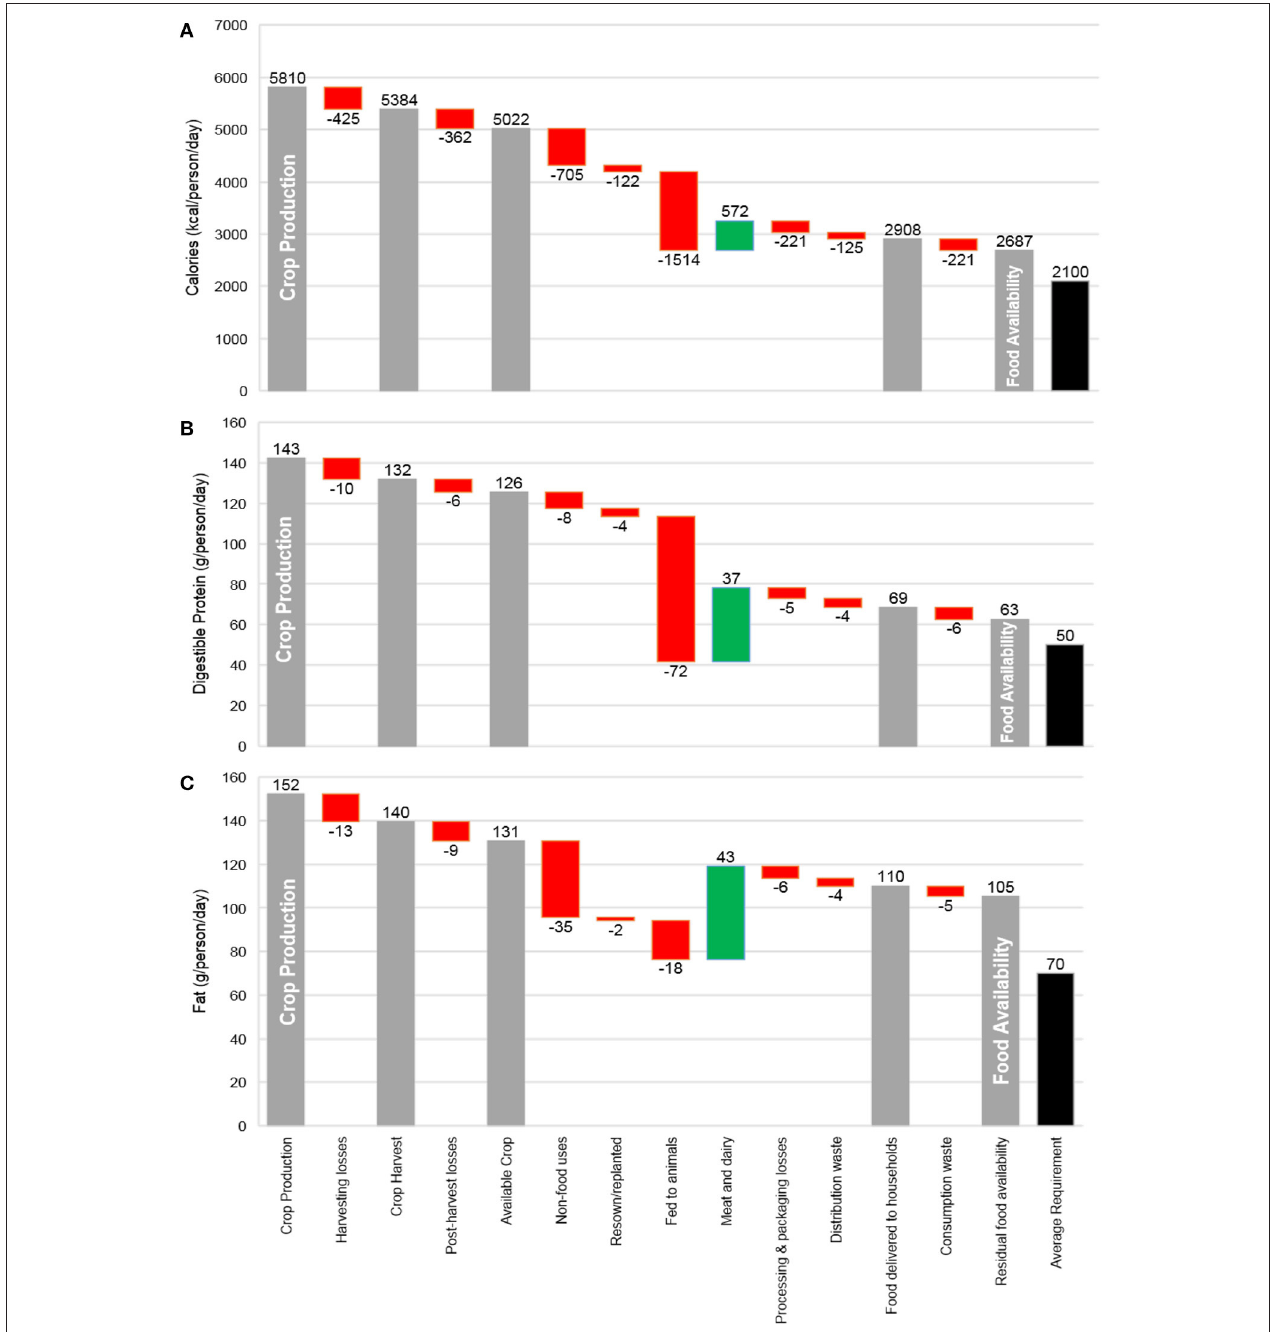
FIGURE 1 | Production and losses in the global food system from “field to fork” in 2011 . Food pathways in (A) calories; (B) digestible protein; and (C) fat from crop production to residual food availability, normalized to average per capita levels assuming equal distribution. Red bars (negative numbers) indicate food system losses; green bars indicate meat and dairy production; and gray bars indicate macronutrient availability at intermediate stages of the chain with the minimum average requirement shown in black.